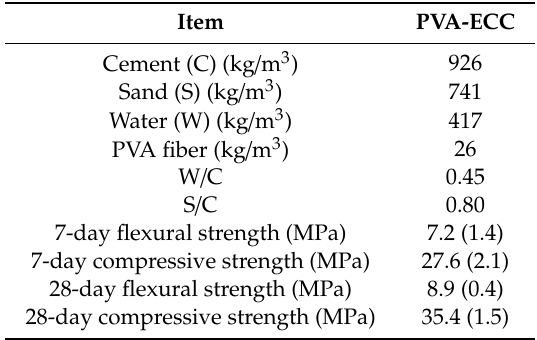
Table 3. Mixture properties of PVA-engineered cementitious composite (ECC) studied (1 m 3 ).